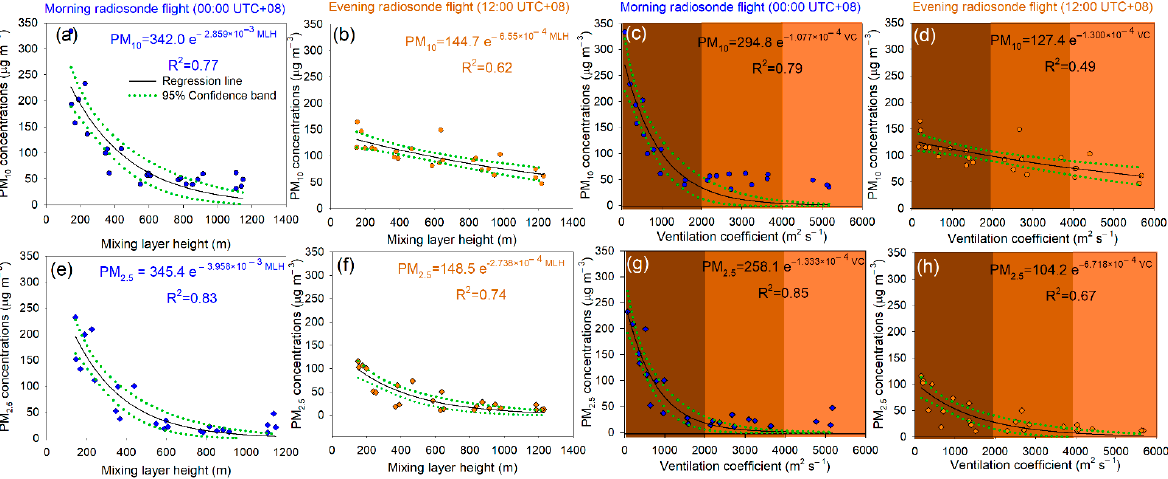
Figure 15. Dependence of monthly average mixing layer height ( a , b , e , f ) and ventilation coefficient ( c , d , g , h ) on PM 10 and PM 2.5 particles in the western part of the city center (West crossroad station) in the morning and evening from 2019 to 2020. The solid line is the regression line, while the dotted green lines are the 95% confidence band. The colored patterns in panels ( c , d , g , h ) are air pollution potential categories: a shift from darker to lighter colors corresponds to a decrease in air pollution potential, indicating cleaner air.